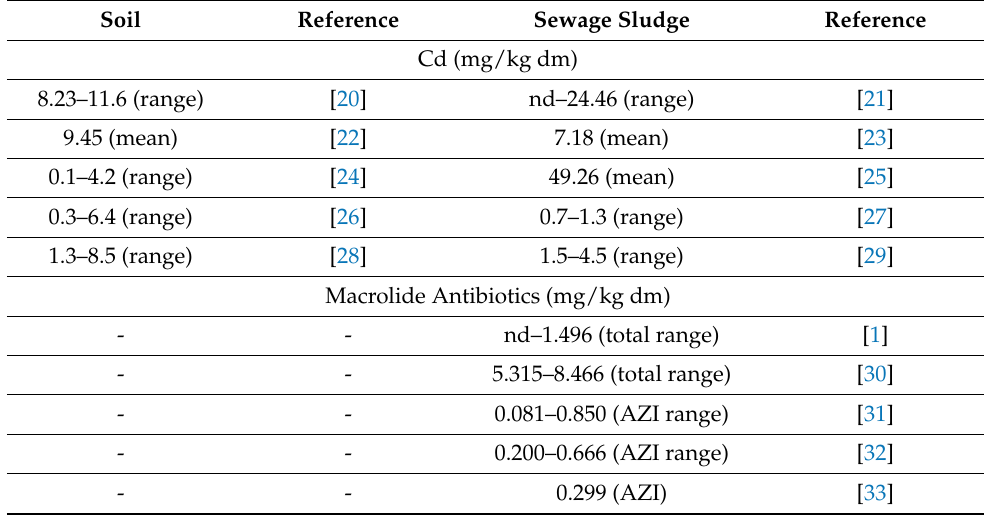
Table 1. Cd and macrolide antibiotics pollution in soil and sewage.